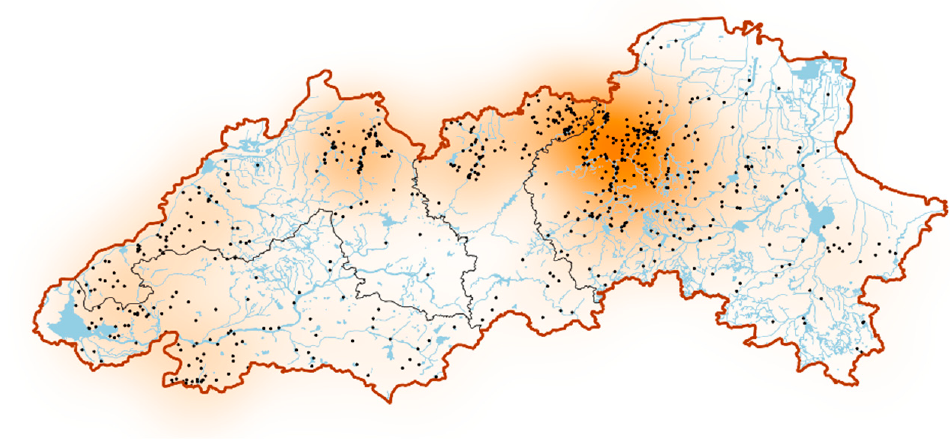
Figure 3. Kernel density of ancient settlements in the Luzhong region during the Shang and Zhou Dynasties.